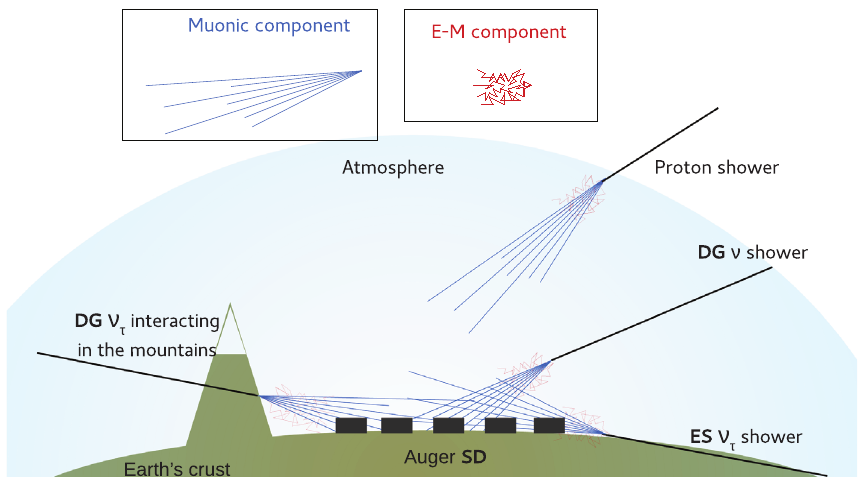
Figure 5. Scheme of the neutrino channels.